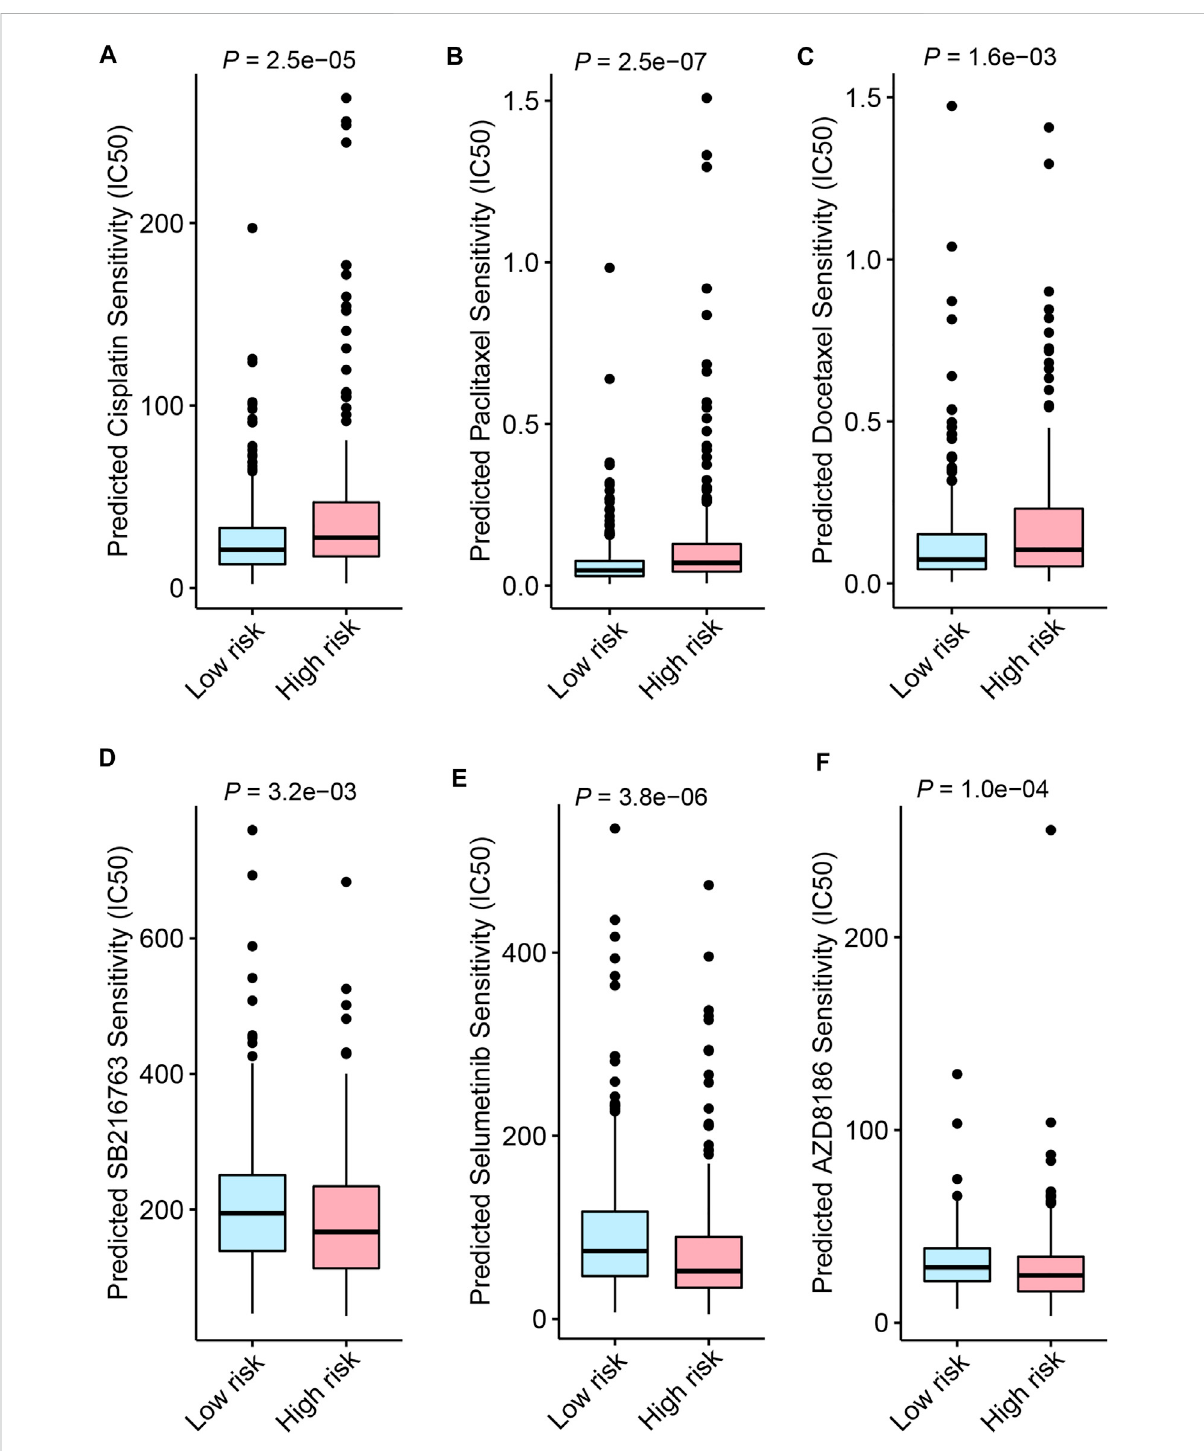
FIGURE 8 Drug sensitivity screening based on the ferroptosis-related lncRNAs signature (FerRLSig) strati fi cation with the Genomics of Drug Sensitivity in Cancer(GDSC)database; (A) Boxplotofthecisplatin half-maximal inhibitoryconcentration(IC50)basedontheFerRLSigstrati fi cation; (B) Boxplotof the paclitaxel IC50 based on the FerRLSig strati fi cation; (C) Boxplot of the docetaxel IC50 based on the FerRLSig strati fi cation; (D) Boxplot of the SB216763 (targetingWNTsignaling pathway)IC50basedontheFerRLSigstrati fi cation; (E) BoxplotoftheSelumetinib(targeting MAPKsignaling pathway) IC50 based on the FerRLSig strati fi cation; (F) Boxplot of the AZD8186 (targeting PI3K signaling pathway) IC50 based on the FerRLSig strati fi